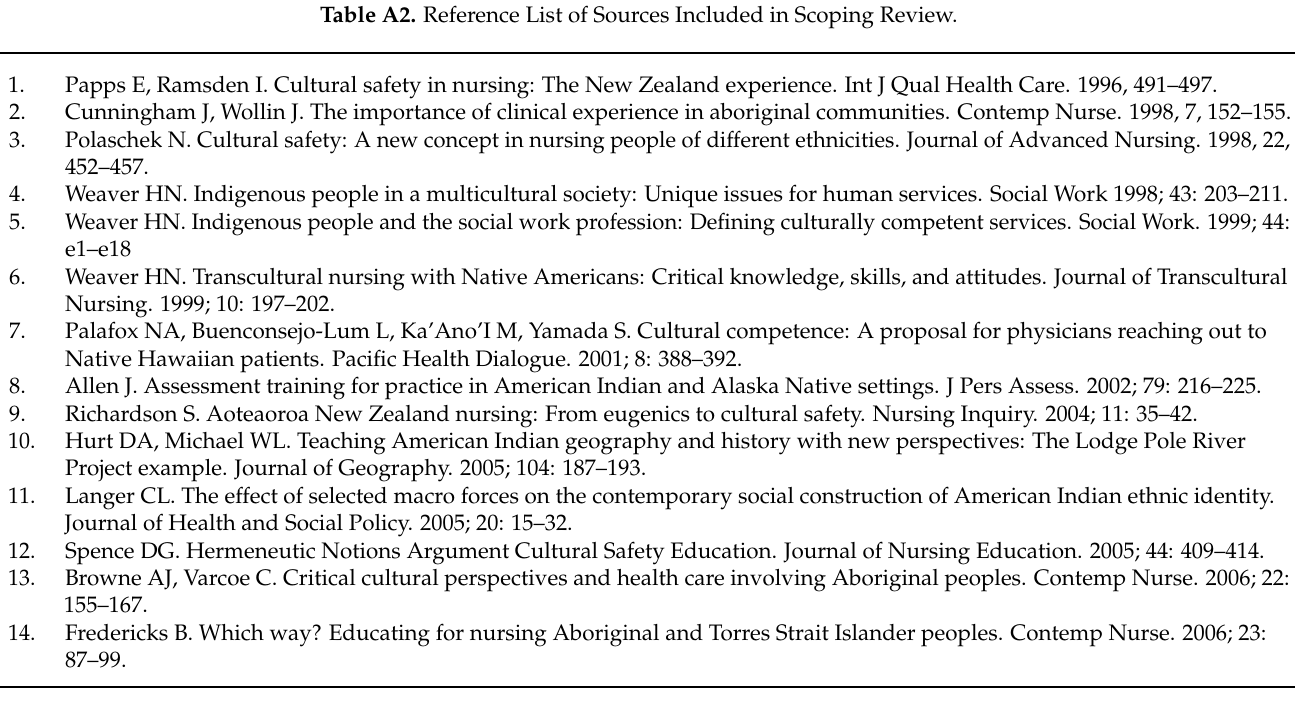
Table A2. Reference List of Sources Included in Scoping